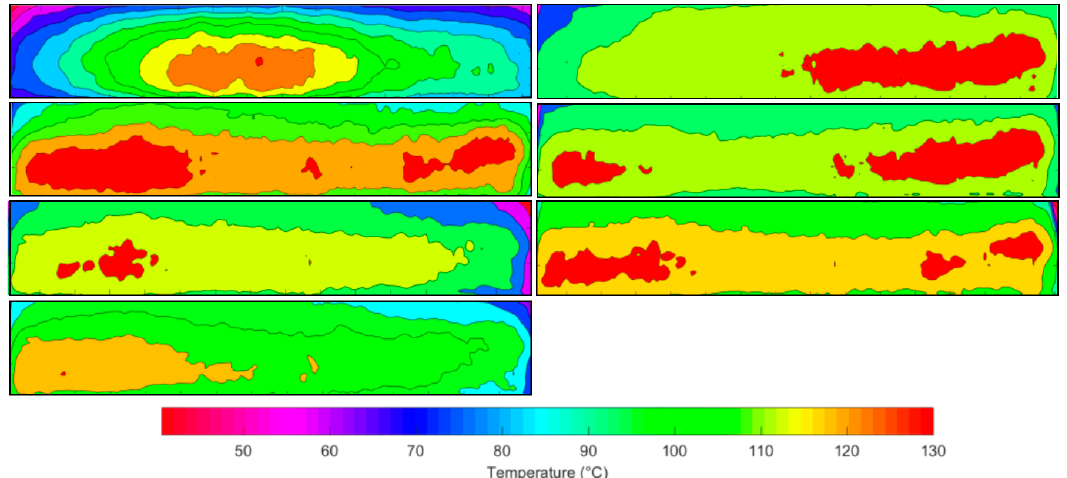
Figure 20. The Greyscale–Threshold plus memory hybrid (GM) method processing is used to treat the element. The result is visualized in contour plots of the surface temperature profile measurements shown after each cycle of ablation.